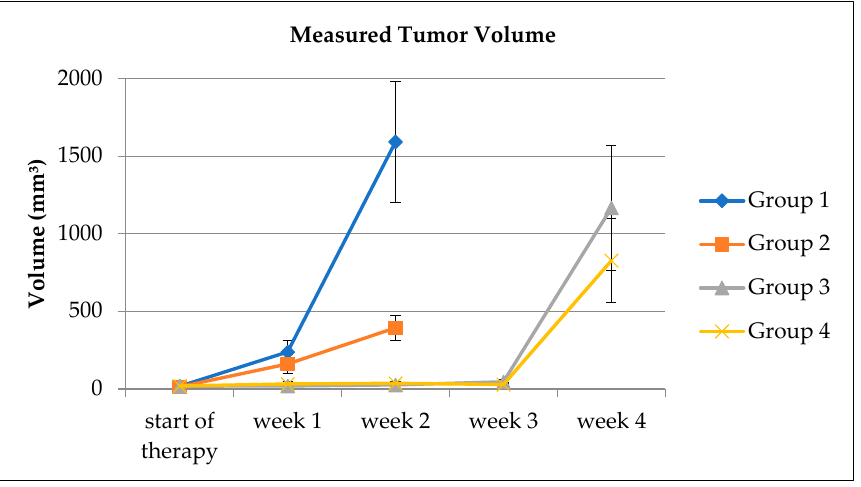
Figure 3. Time course of the manually measured tumor volumes averaged in the different groups. Error bars indicate the standard error of the mean.